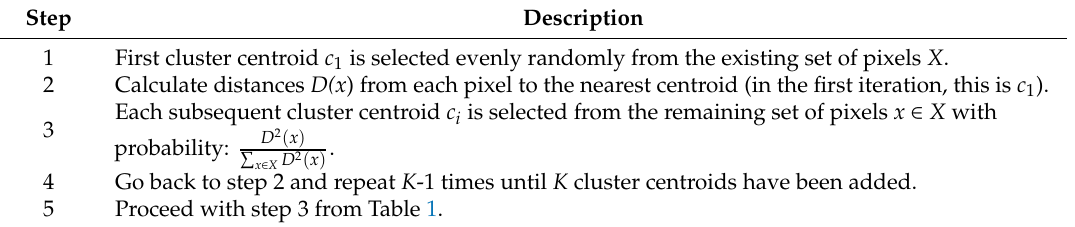
Table 2. The k-means ++ cluster centroid initialization method